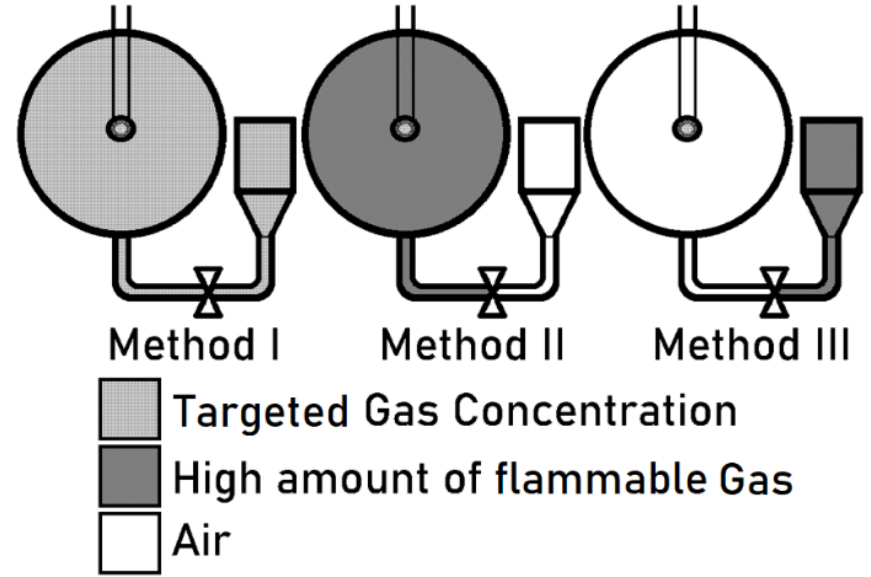
Figure 1. Three different ways of mixing; Gas concentration before opening the fast-acting valve between 20 L-sphere and dust container [3].